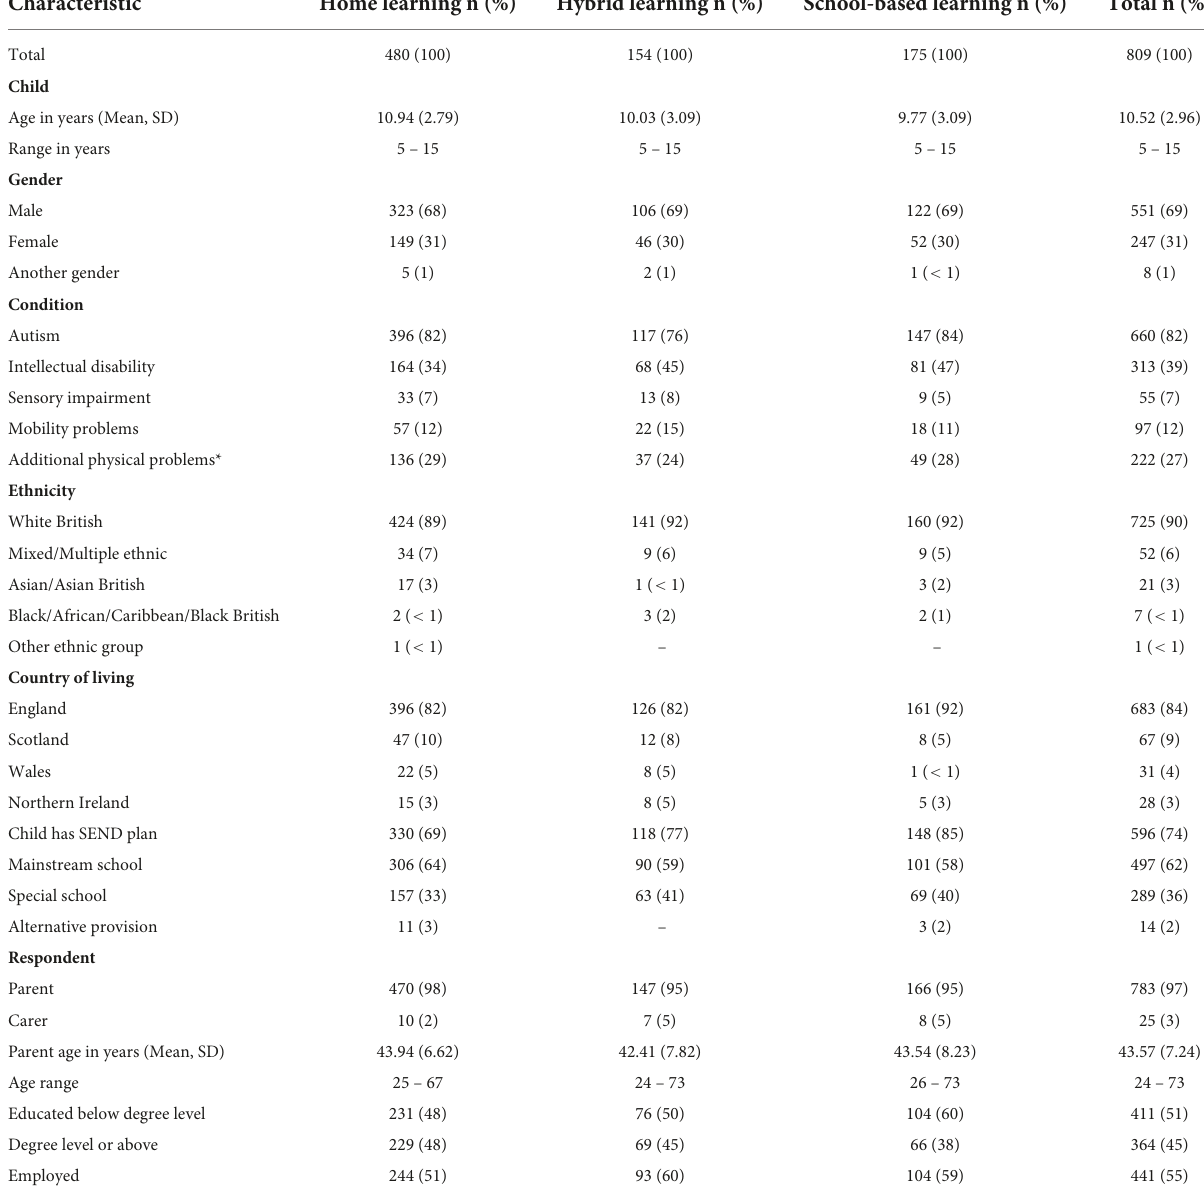
TABLE 1 Sociodemographic characteristics of children with neurodevelopmental conditions and their families.